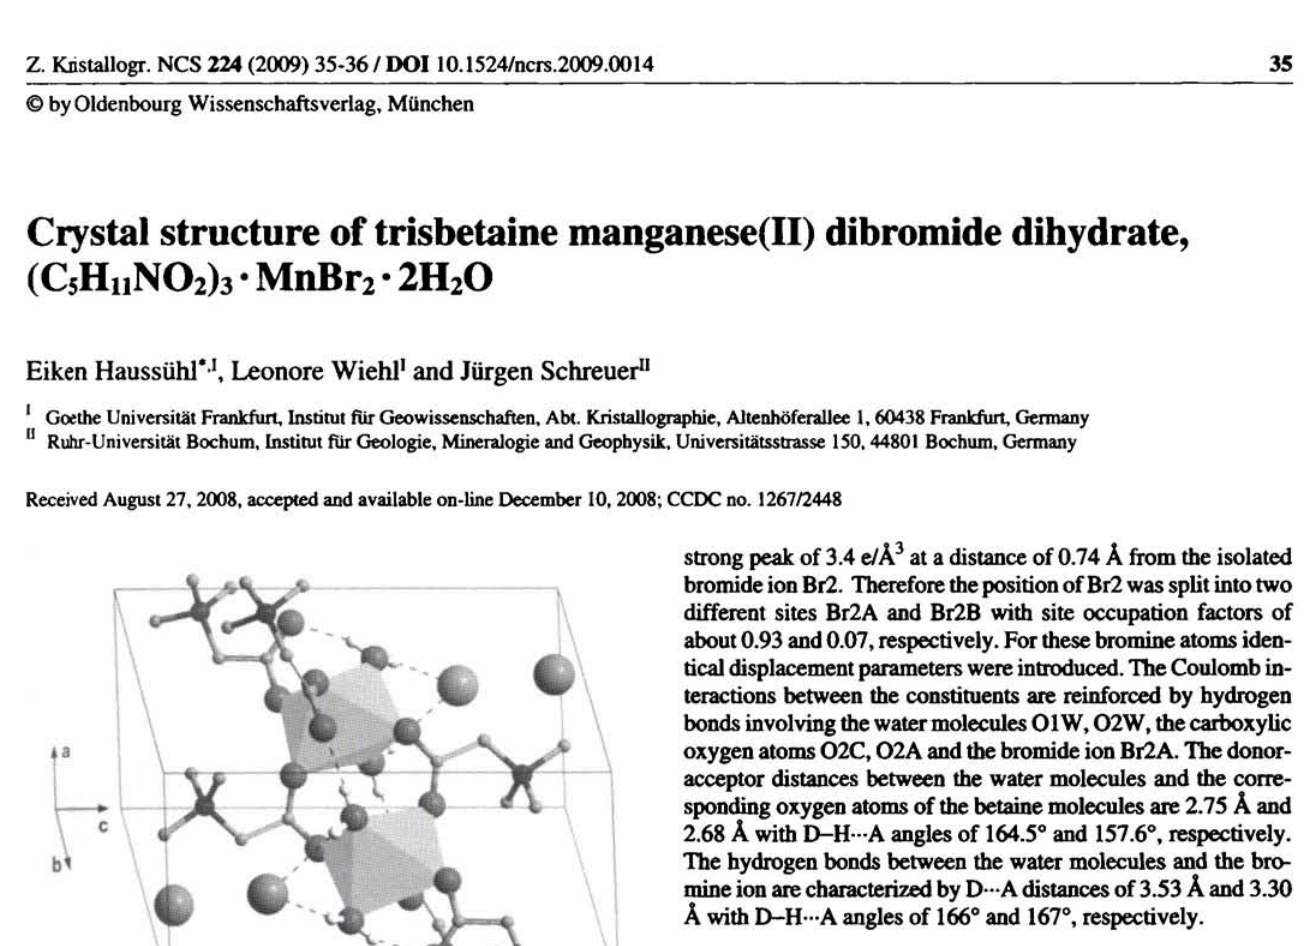
Table 1. Data collection and handling.